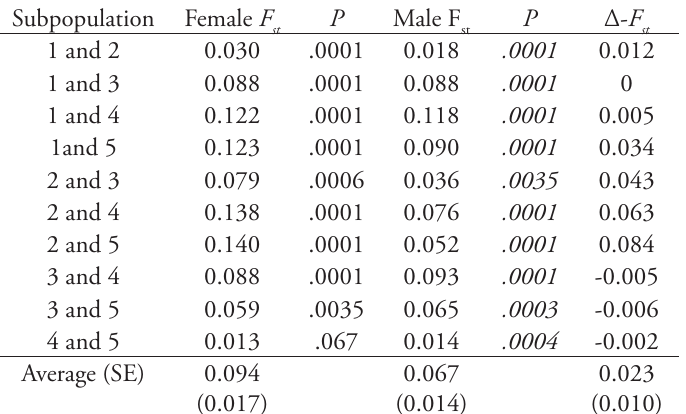
Table 4. Pairwise F values for females and males separately between st five geographic subpopulations of Norwegian red deer identified by Bayesian assignment and the difference between pairs (∆- F ties that F values differ from zero ( P ) and significance after sequential st Bonferroni correction in italic .